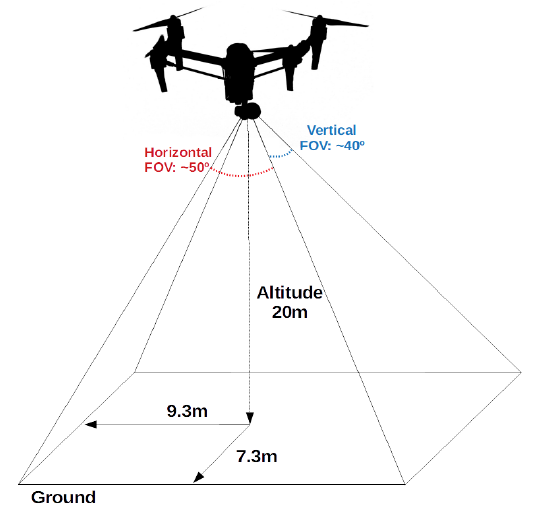
Figure 14. The UAV field of view at 20 m of